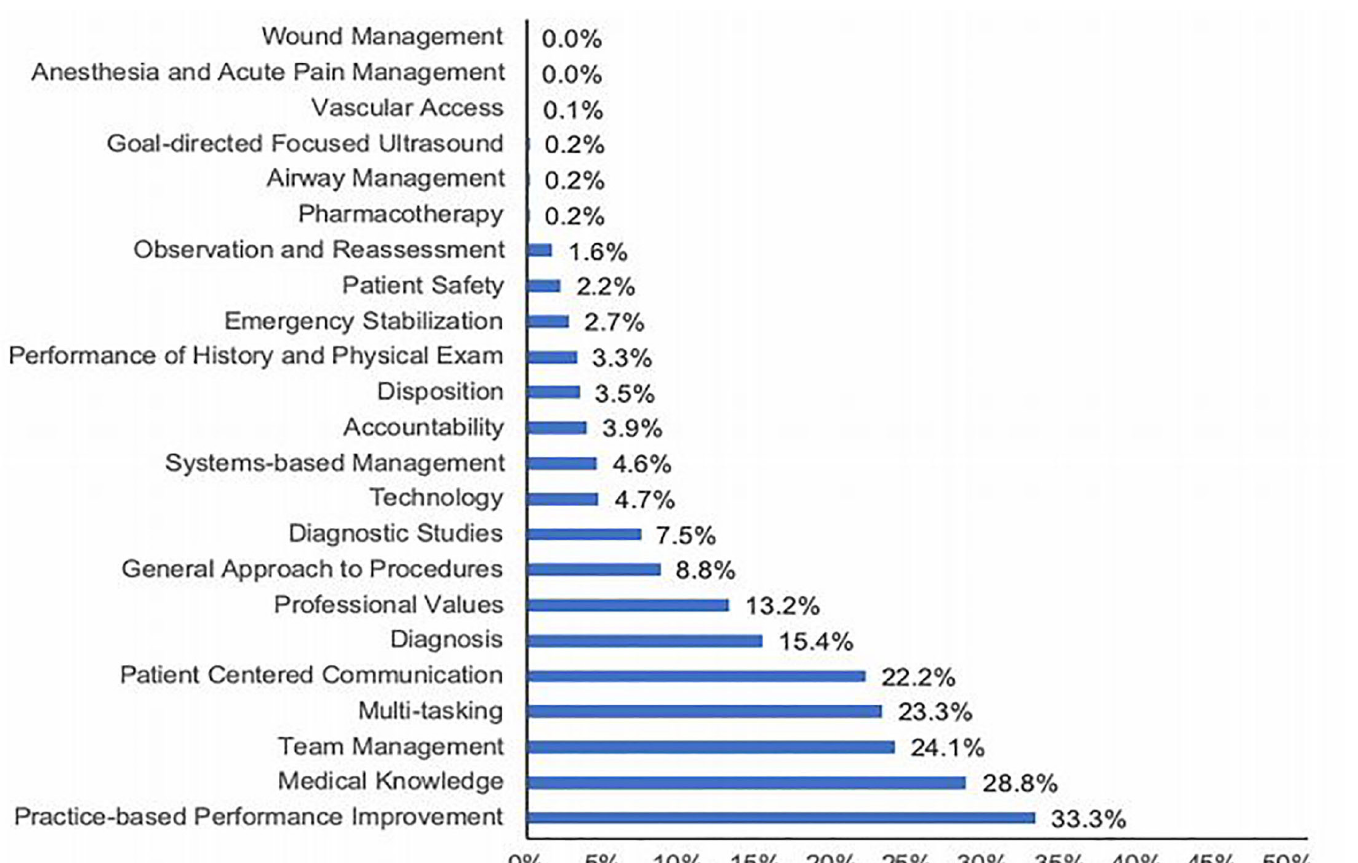
Figure. Frequency of emergency medicine milestone sub-competencies identified per workplace-based narrative